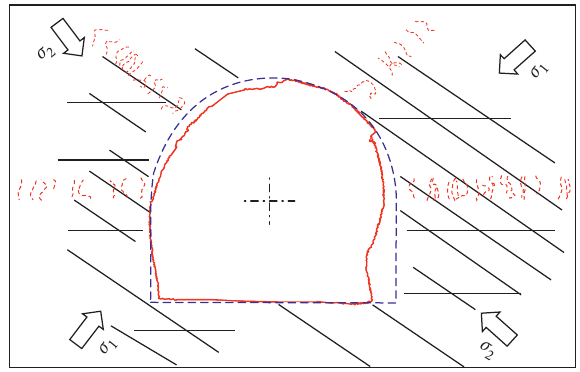
Figure 18: Preliminary mechanism of large deformation.